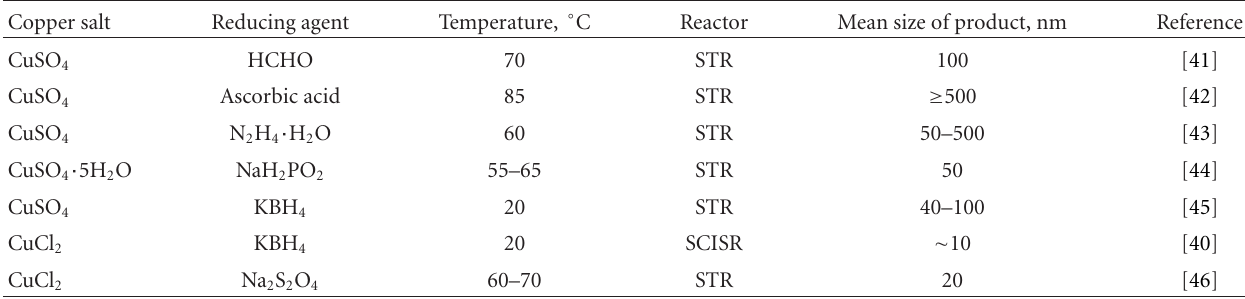
Table 3: Comparison of average sizes of nanocopper products obtained by various processes and with various reactors. Copper salt